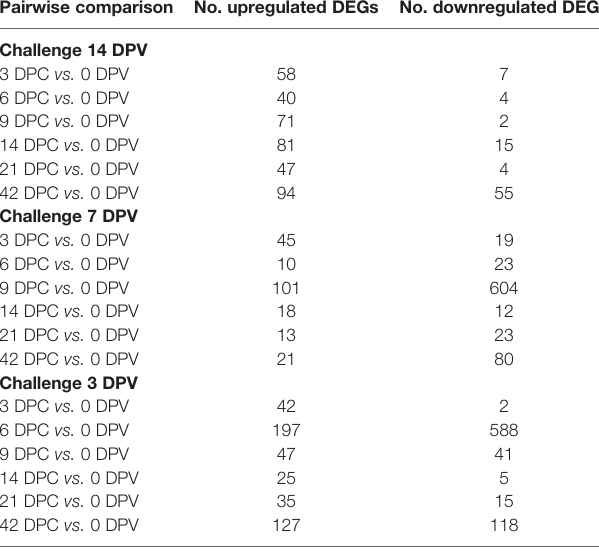
DEGs are de fi ned as those with at least 2-fold change in expression relative to 0 DPV with an FDR-corrected p value <0.05 and an average RPKM of 5. The DEGs listed are protein-coding and human homolog genes. DEG,differentiallyexpressedgenes;DPV,dayspost-vaccination;No.,number;DPC,days